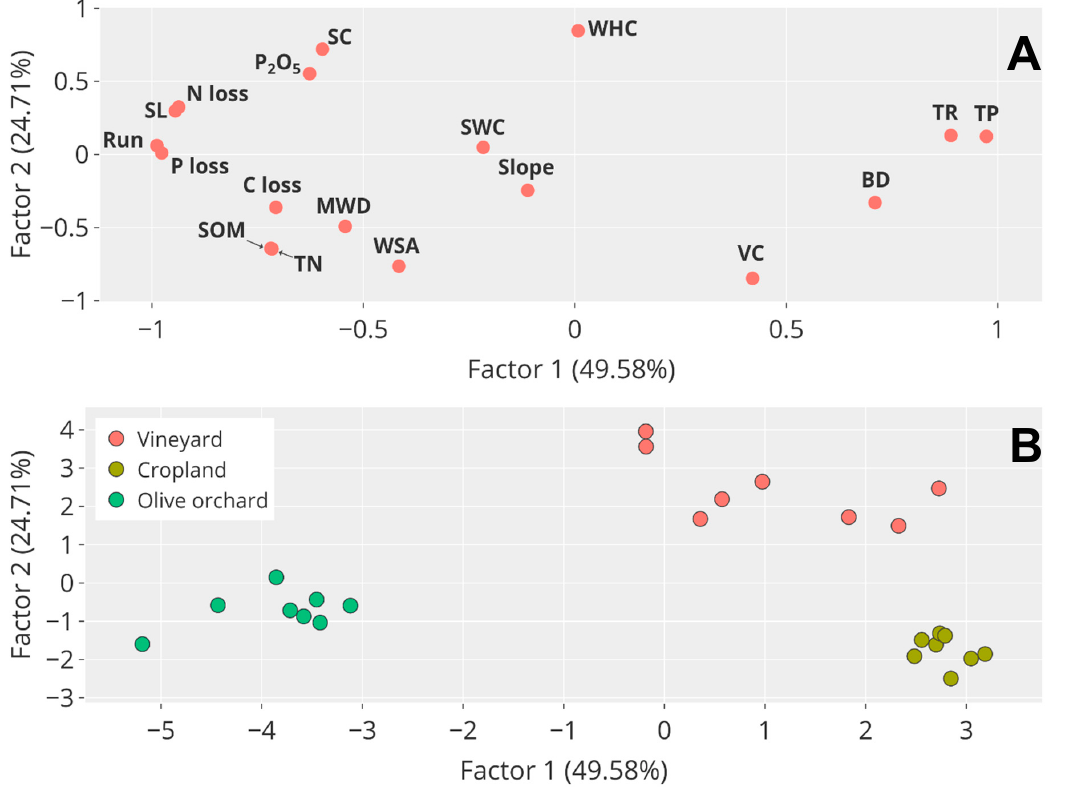
Figure 3. Relation between Factors 1 and 2, ( A ) Variables and ( B ) Cases. VC, vegetation cover; BD, bulk density; WHC, water holding capacity; SWC, soil water content; MWD, mean weight diameter; WSA, water stable aggregates; SOM, soil organic matter; P 2 O 5 , available phosphorous; TN, total nitrogen; TP, time to ponding; TR, time to runoff; Run, runoff, SC, sediment concentration; SL, sediment loss; N loss, nitrogen loss, C loss; carbon loss and P loss; phosphorous loss.